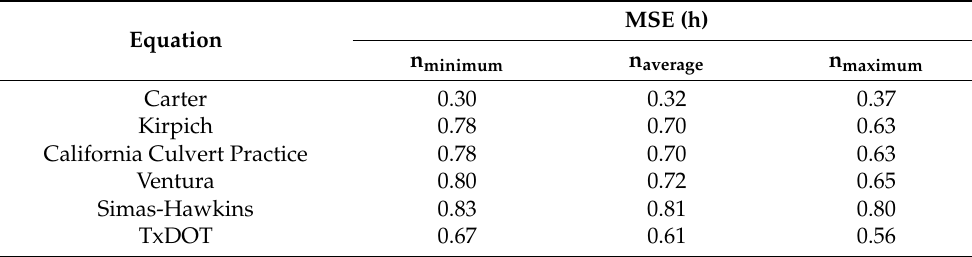
Table 9. MSE calculated for the different equations changing the roughness